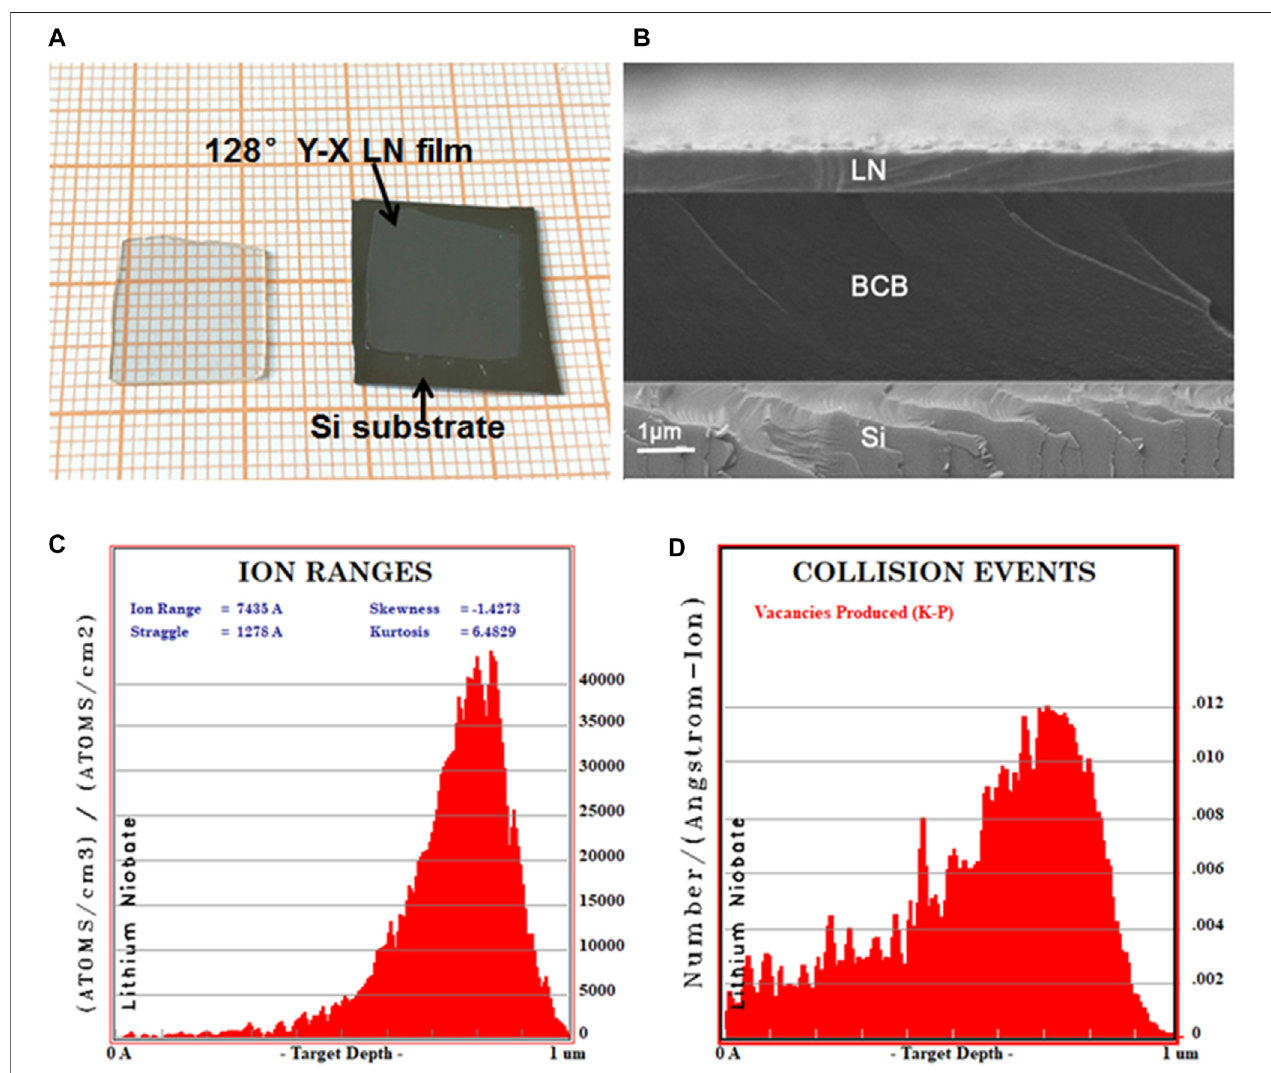
FIGURE 6 | (A) the photographs of 128 ° Y – X LN POS substrate, (B) The cross-section picture of 128 ° Y – X LN POS structure inspected by SEM, (C) He ions, and (D) vacancies distribution in LN crystal at 200 KeV implantation energy simulated by SRIM.